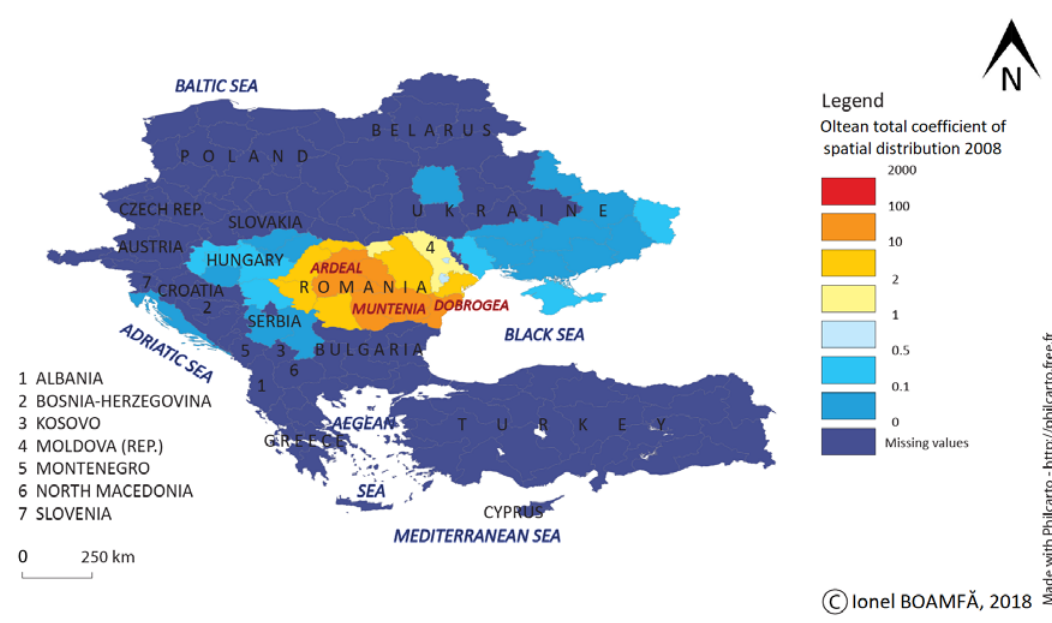
Figur e 9. G eographical repartition of the anthroponym Oltean. Coef. of spatial